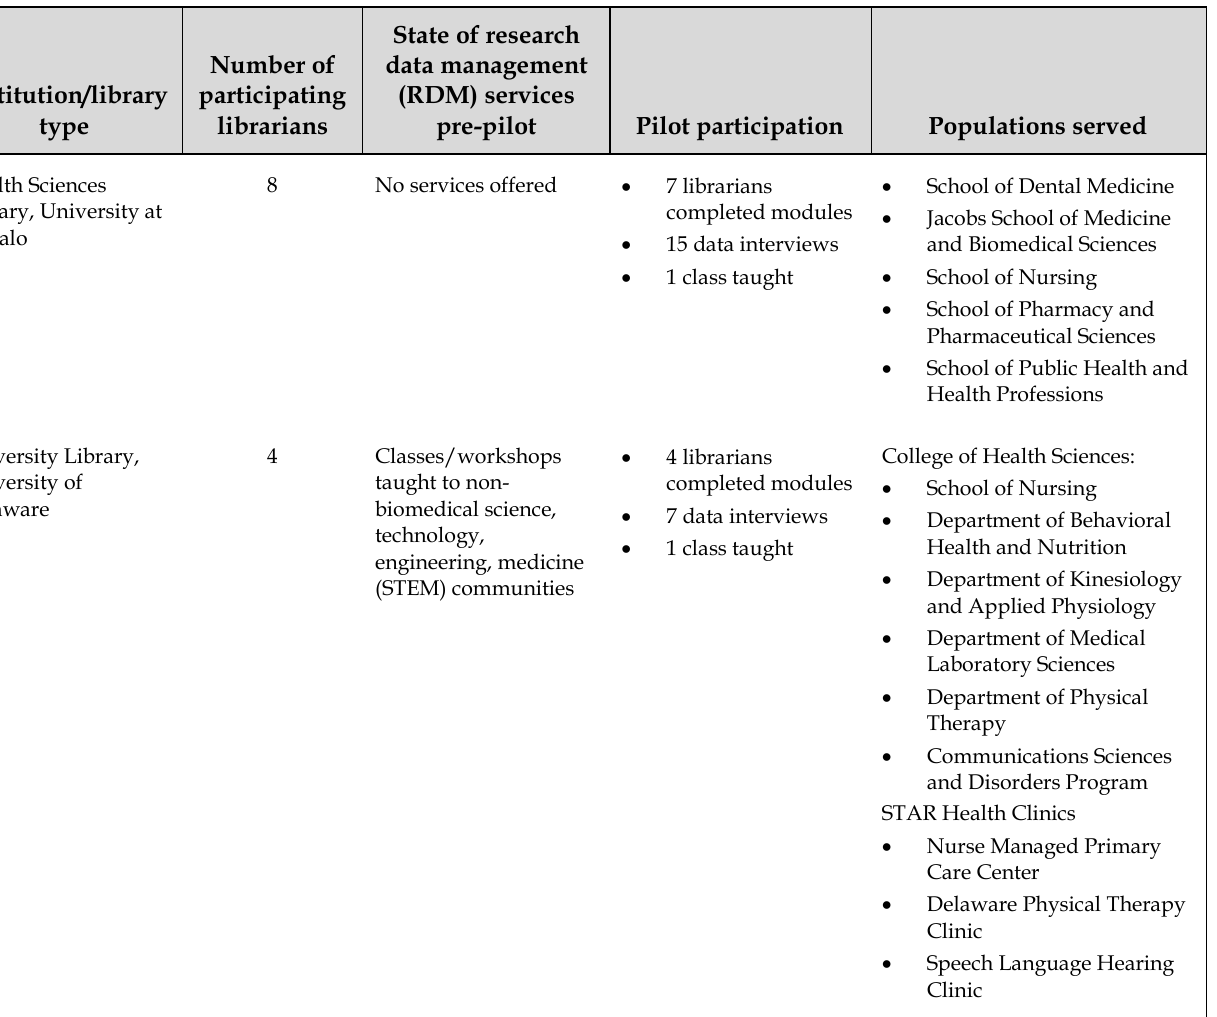
Table 1 Overview of pilot